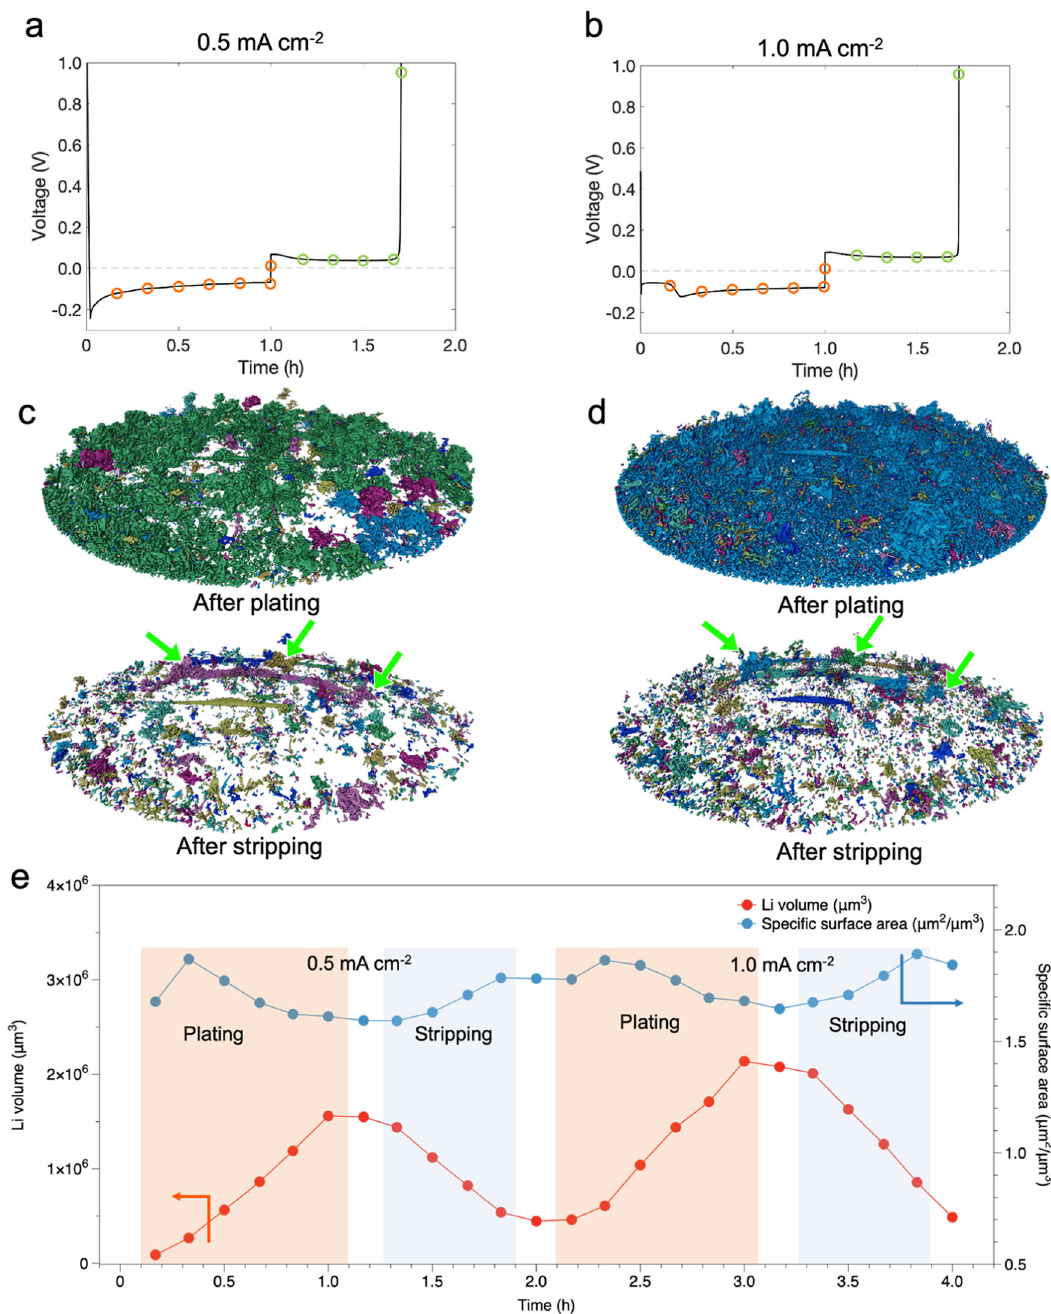
Fig. 2 | Renderings of the segmented Li from operando X-ray tomograms. a , b Voltage pro fi les of galvanostatic plating/stripping during operando XTM at 0.5mAcm − 2 forthe fi rstcycle( a )andat1.0mAcm − 2 inthesecondcycle( b ).Circles indicate where X-ray tomograms were taken, and orange color represents plating process while green color represents stripping process. c , d 3D renderings of segmented Li and identi fi cation of isolated regions, rendered as distinct colors. Rendering of tomograms taken after plating and after stripping at 0.5mAcm − 2 ( c )